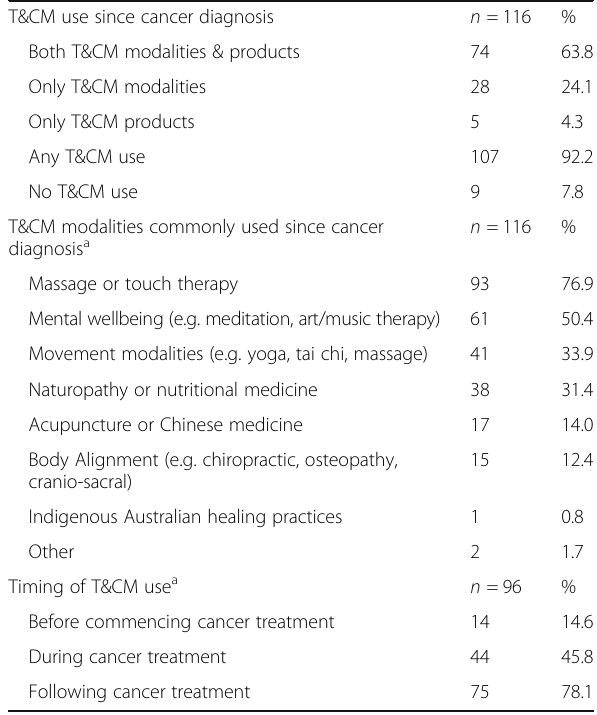
Table 3 Survey participants ’ use of traditional and complementary